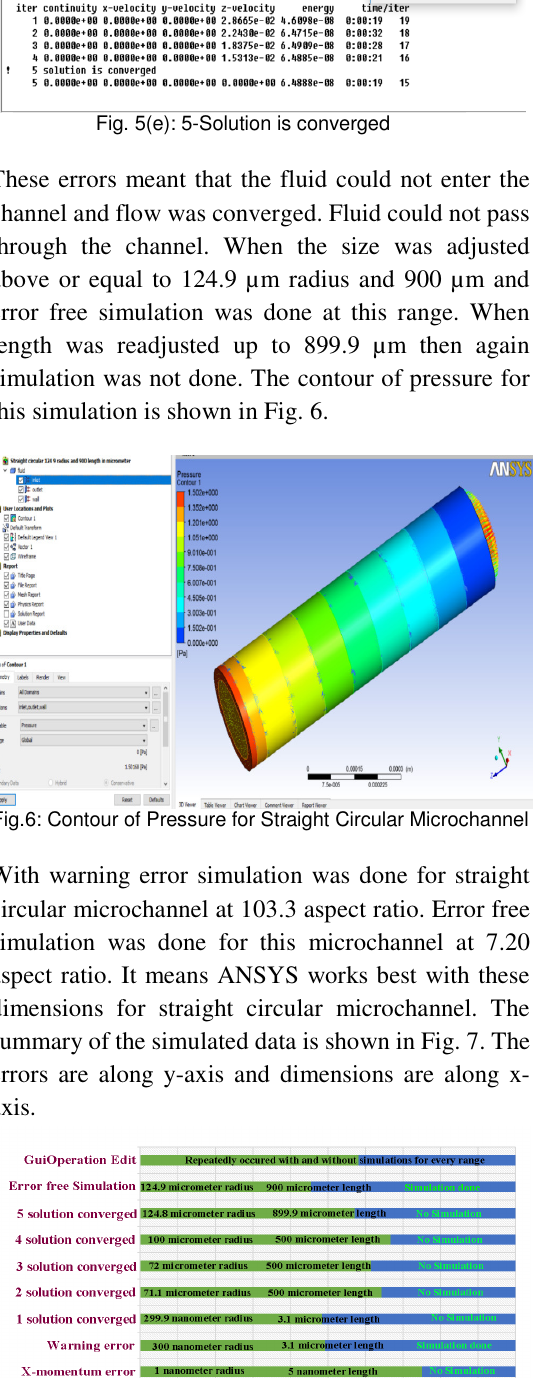
Fig. 7: Graphical Summary of Straight Circular